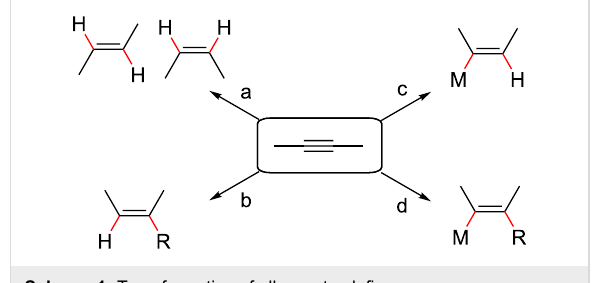
Scheme 1: Transformation of alkynes to